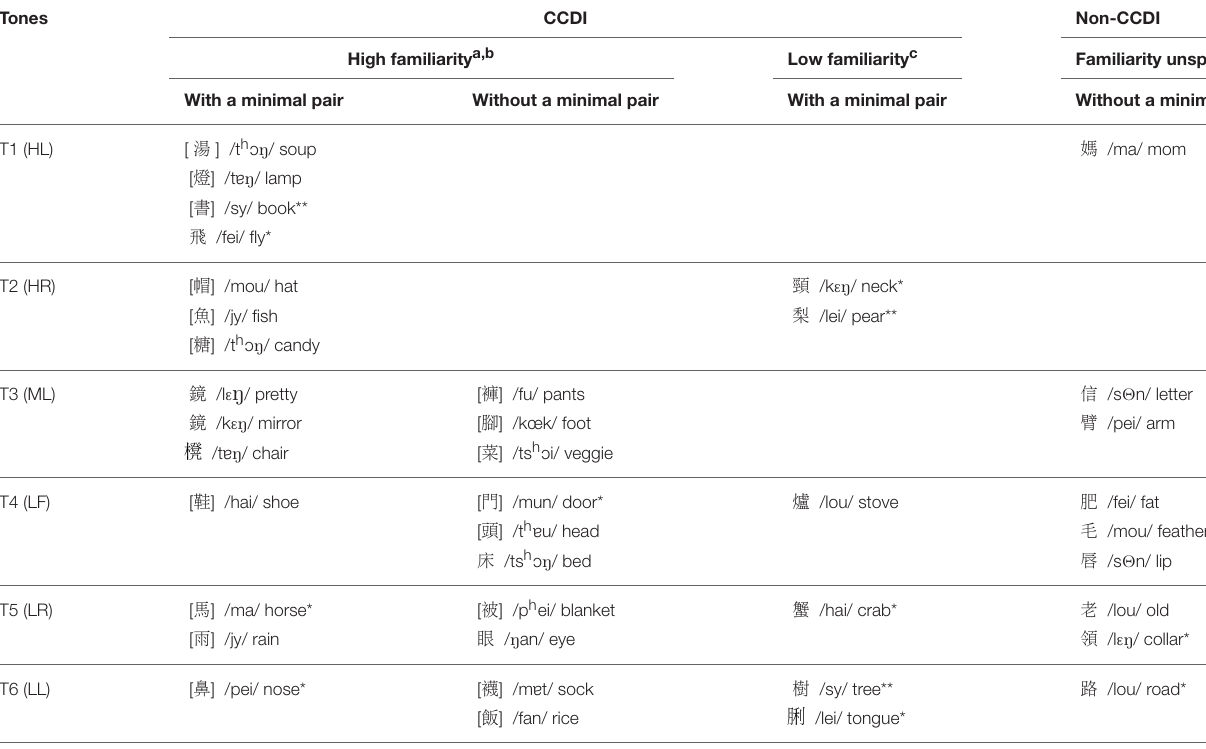
TABLE 2 | Word stimuli for tone